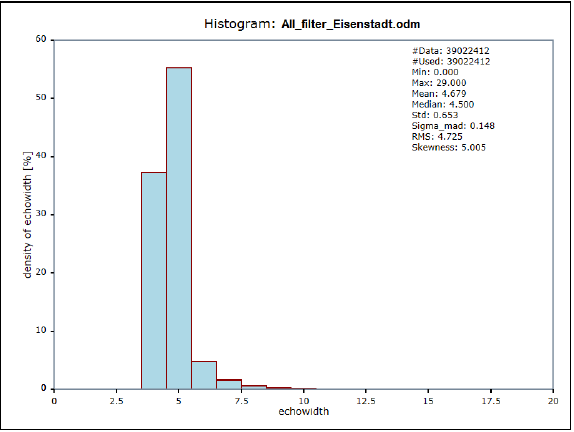
Figure 5. Histogram of echo width value in Eisenstadt region